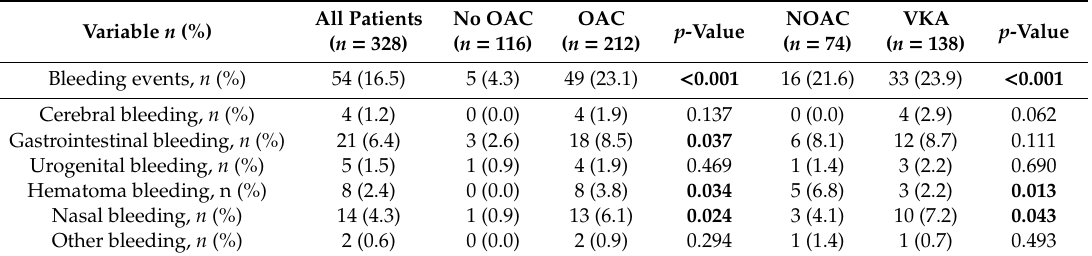
Table 2. Clinically relevant bleeding events in orally anticoagulated patients versus the remainder of the study